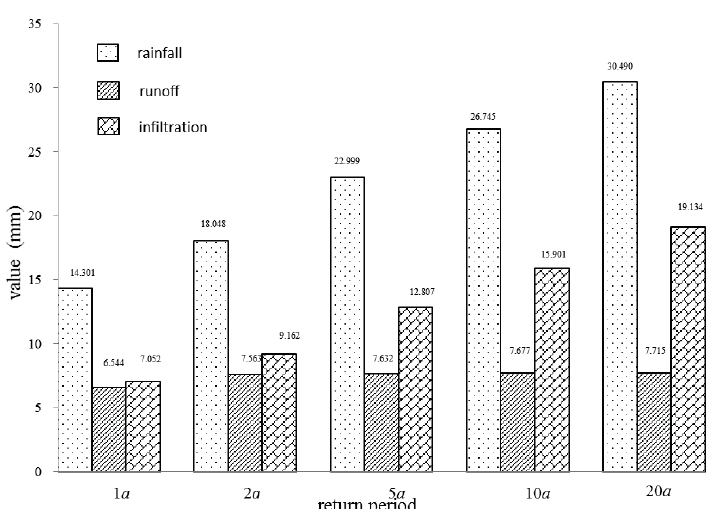
Fig. 4 Simulated surface runoff with different return periods design precipitation.